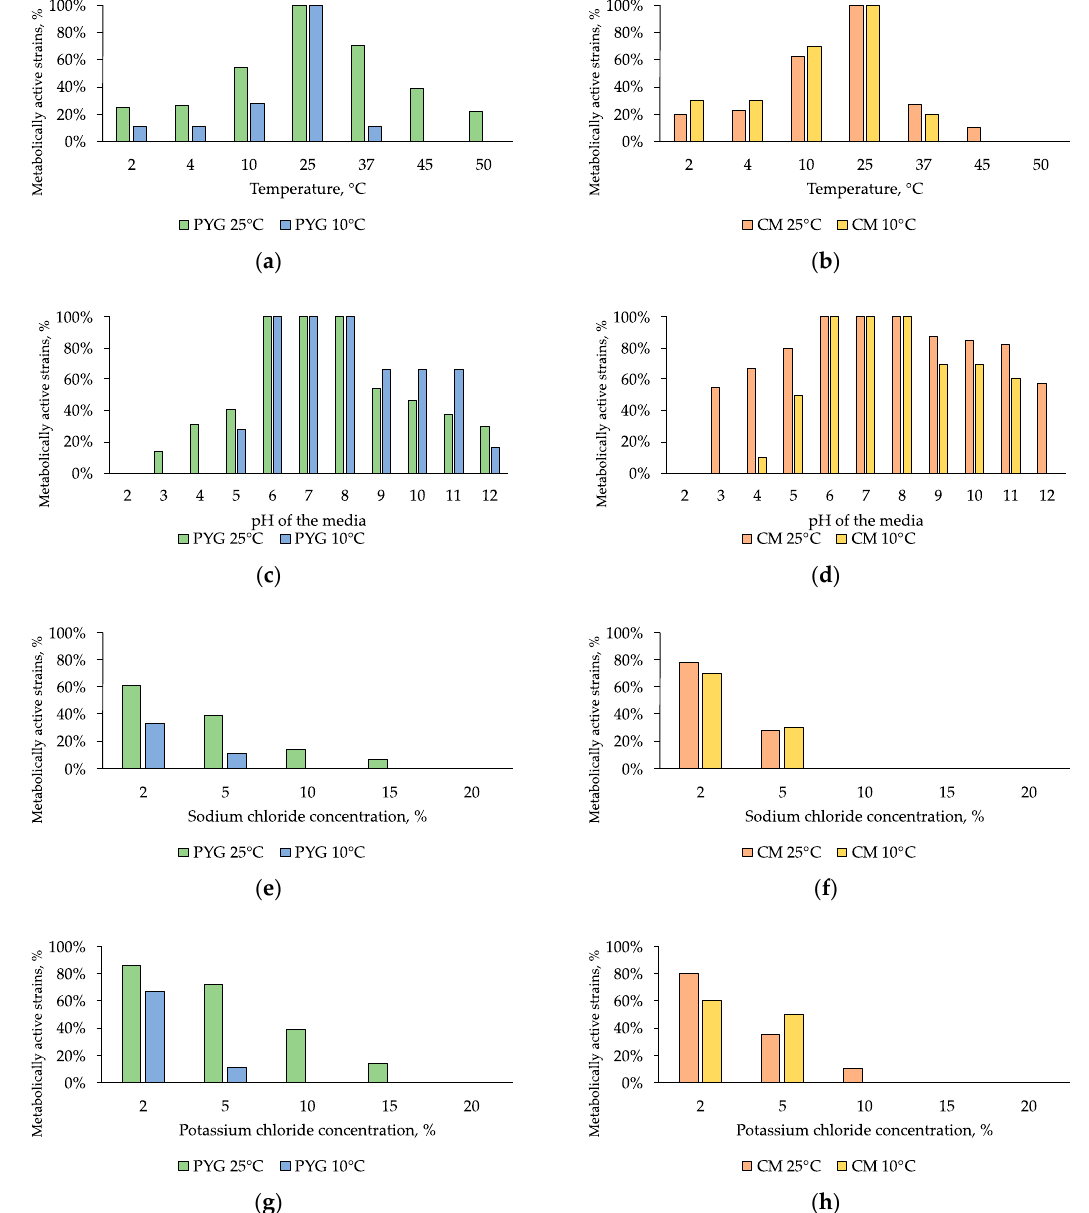
Figure 7. Isolated strains resistance to: ( a ) , ( b )—cultivation temperature; ( c ) , ( d )—pH of the media; ( e ) , ( f )—sodium chloride, ( g ), ( h )—potassium chloride. Left column: strains isolated on PYG medium; right column—strains isolated on CM medium.